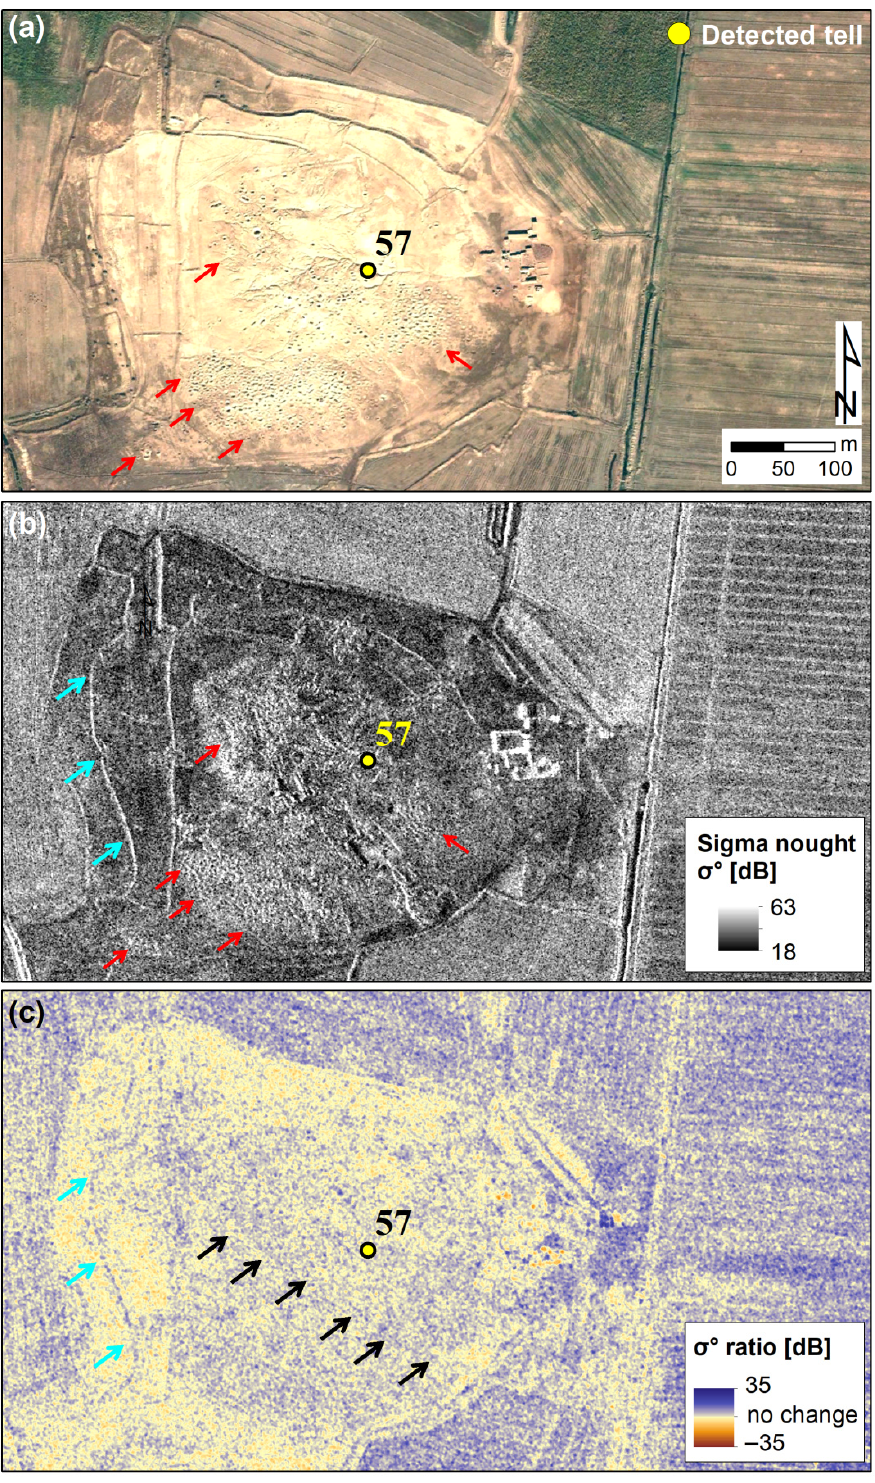
Figure 14. ( a ) VHR optical (21 November 2004) and ( b ) multi-temporal average COSMO-SkyMed Enhanced Spotlight (27 July 2019–24 March 2020) images showing clear evidence of looting at Tulul el-Barakat TB1 site (id.57, known from [70]). Impact and extent of 2019–2020 anthropogenic disturbance are highlighted through ( c ) COSMO-SkyMed amplitude change detection map. Google Earth image © 2021 Maxar Technologies; COSMO-SkyMed ® Products ©ASI, Italian Space Agency,